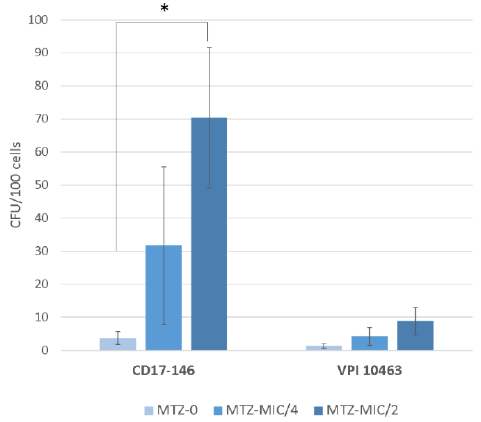
Figure 5. Impact of MTZ on adherence of VPI 10463 and CD17-146 strains to Caco-2TC7 cells. Overnight cultures of each C. difficile strain in BHISG broth, with or without subinhibitory concen- trations of antibiotics, were pelleted and washed once with PBS, then incubated with Caco-2/TC7 cells in DMEM for 1 h 30 at 37 ◦ C under anaerobic conditions. The adhesion ability was expressed as the number of adherent bacteria per 100 Caco-2/TC7 cells. The adherence to Caco-2/TC7 cells of CD17-146 exposure to MTZ at MIC/2 increased significantly. Data are representative of at least three independent experiments, each performed in triplicate. The error bars represent standard error of the mean (SEM). Significantly differences ( p < 0.05) are indicated by asterisks (Man-Whitney